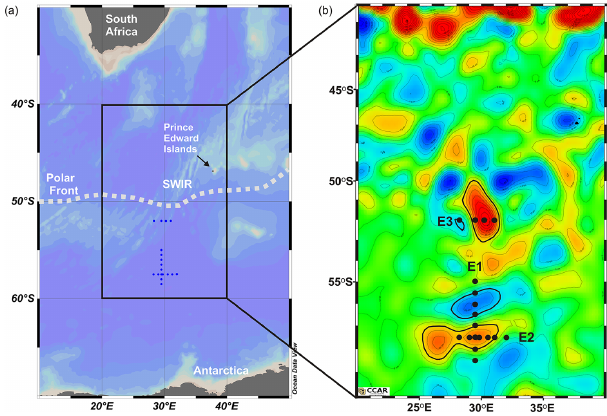
Figure 1. (a) Seafloor bathymetry in the southwestern Indian Ocean sector of the Southern Ocean to indicate the position of the South- west Indian Ridge (SWIR); shown in grey is the average position of the polar front (adapted from Dong et al., 2006). (b) The CTD sta- tion locations along transect lines E1 to E3 are shown as black dots superimposed upon a satellite altimetry map; red indicates positive SSHAs and blue indicates negative SSHAs. SSHA contour intervals are 5cm, and the − 10cm and + 10cm contour lines that the transect lines cross are highlighted with solid black lines.